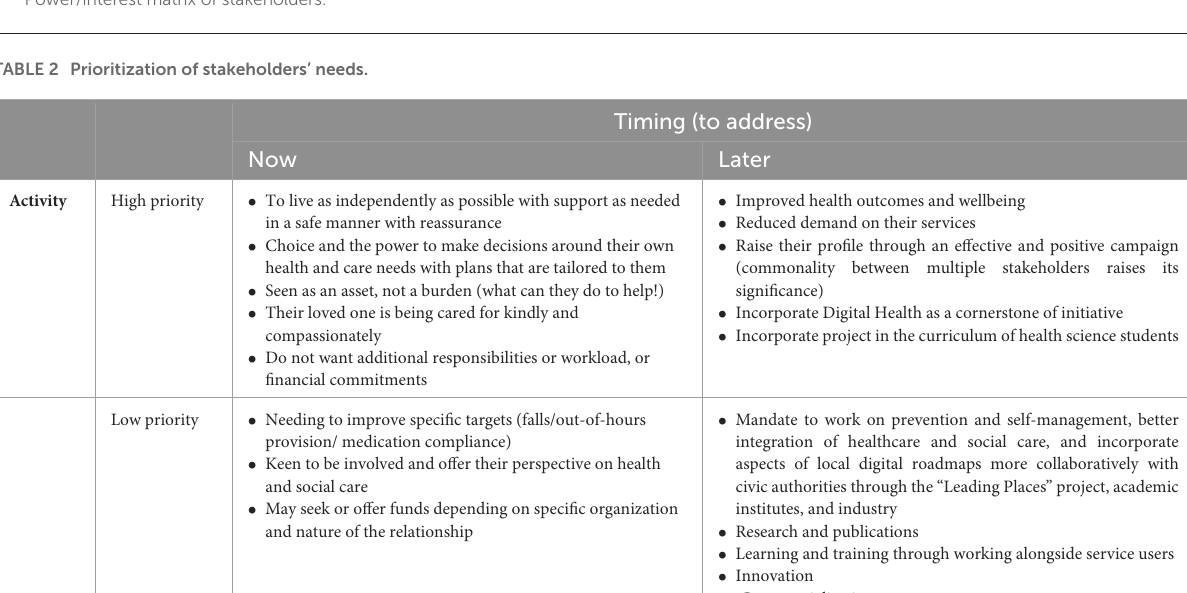
FIGURE2 Power/interest matrix of stakeholders.